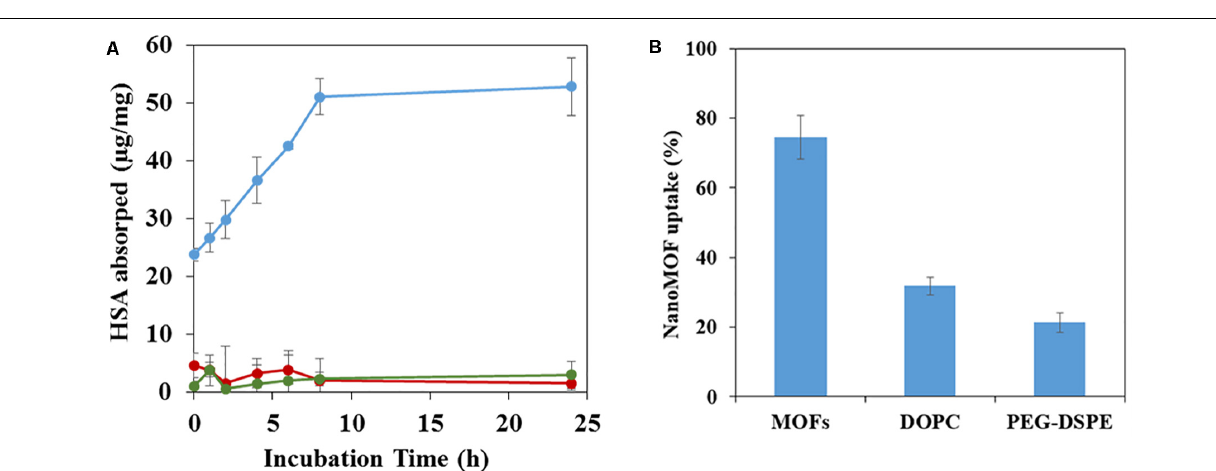
FIGURE 8 | HSA adsorption assayed by BCA assay (A) and J774 murine macrophage uptake (B) of nanoMOFs before and after lipid surface functionalization. (A) HSA adsorption by nanoMOFs before (blue) and after lipid coating with (red) or without (green) the addition of DSPE-PEG 2000. (B) NanoMOFs (before and after lipid coating, with or without addition of DSPE-PEG 2000) internalization inside murine macrophage J774 cells. 50 µ g/mL nanoMOFs were incubated with 3 × 10 5 J774 cells for 4 h, and the amount of internalized nanoMOFs was determined by ICP-MS and expressed as a% of the initial nanoMOF amount in contact with the cells. Significant difference was observed for nanoMOFs before and after surface modification ( p <